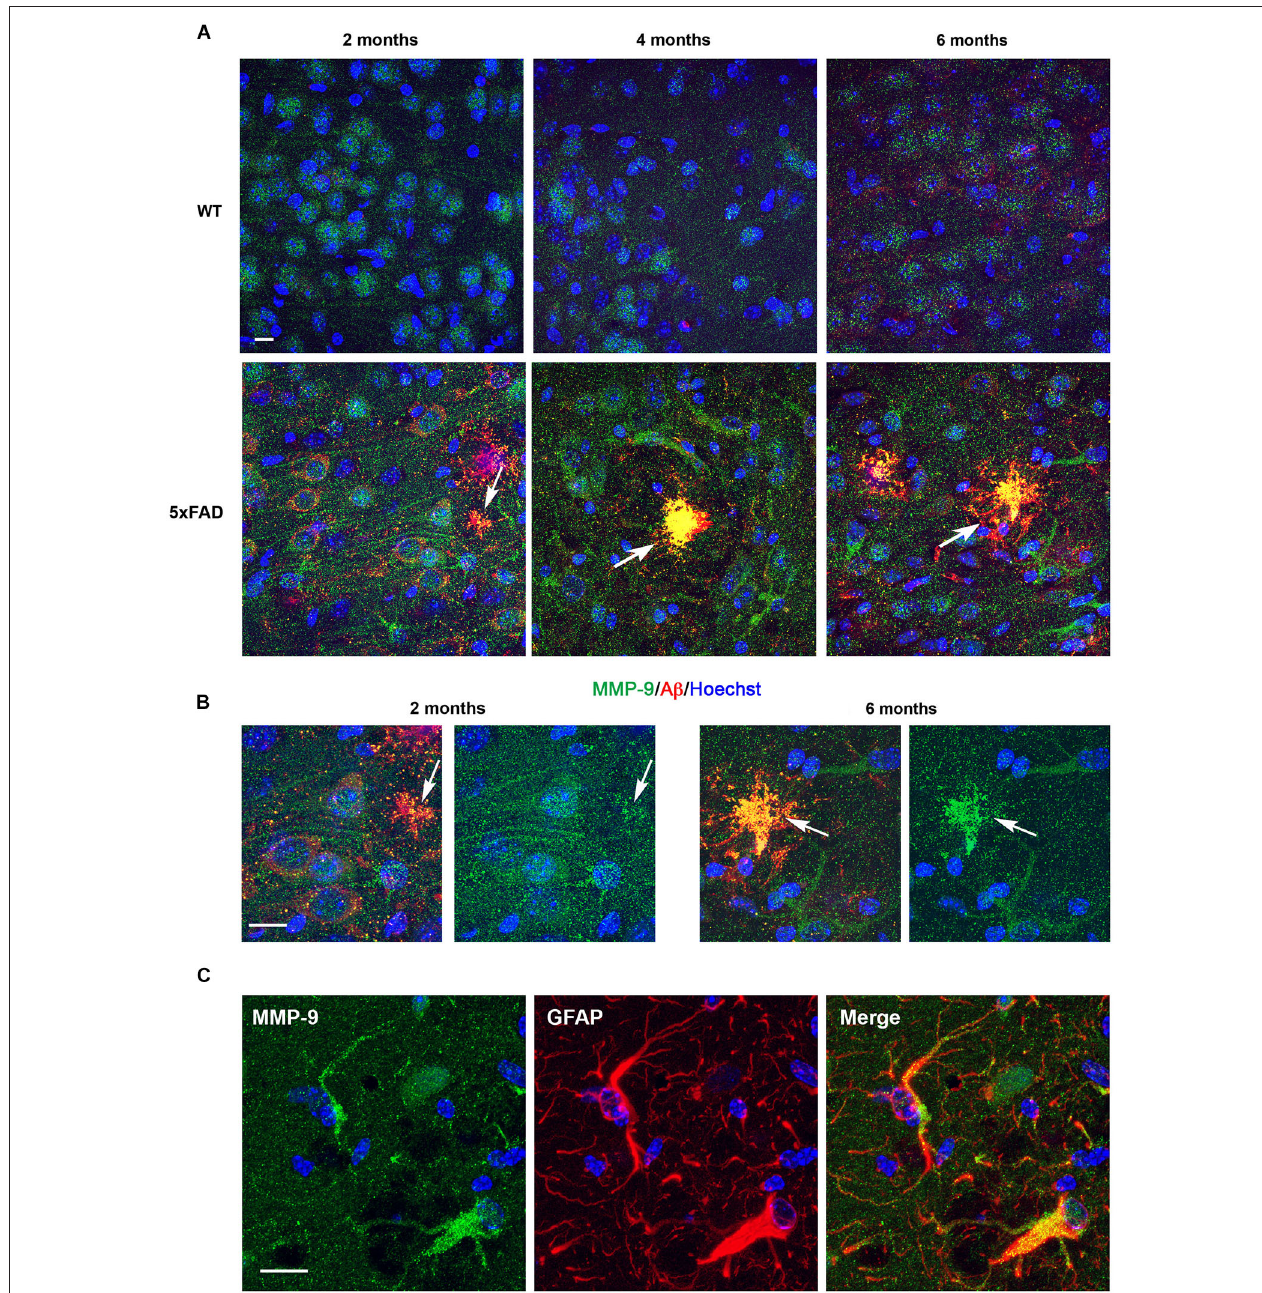
shows incipient localization to amyloid plaques, as revealed by yellow color (arrows). MMP-9 immunostaining increases with age in astrocytes of 5xFAD mice, and at 4 and 6 months colocalization with amyloid plaques is noticeable. Hoechst (blue) labels cell nuclei. (B) High power magnifications of 5xFAD subiculum at 2 and 6 months showing age-dependent increased association of MMP-9 with amyloid deposits. (C) Confocal microphotographs showing localization of MMP-9 (green) to GFAP+ astrocytes (red) of 5xFAD mice. Scale bars: 10 µ